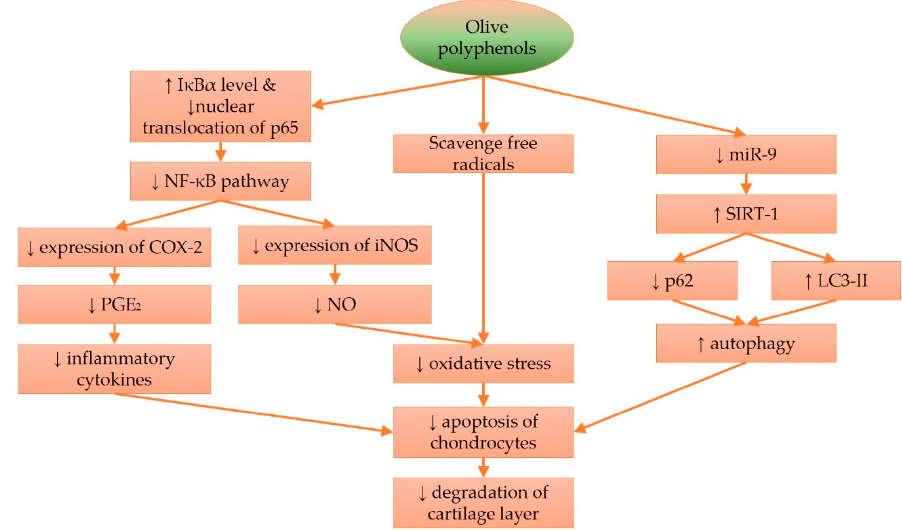
Figure 1. The mechanisms of action of olive polyphenols in preventing osteoarthritis. Abbreviations: COX-2 = cyclooxygenase-2; I κ B α = nuclear factor of kappa light polypeptide gene enhancer in B-cells inhibitor, alpha; iNOS = inducible nitric oxide synthase; miR= microRNA; NF κ B = nuclear factor kappa-light-chain-enhancer of activated B cells; LC3-II = microtubule-associated protein 1A/1B-light chain 3 conjugate, p62 = nucleoporin p62; p65 = transcription factor p65; PGE 2 = prostaglandin E 2 ; SIRT-1 = sirtuin-1.